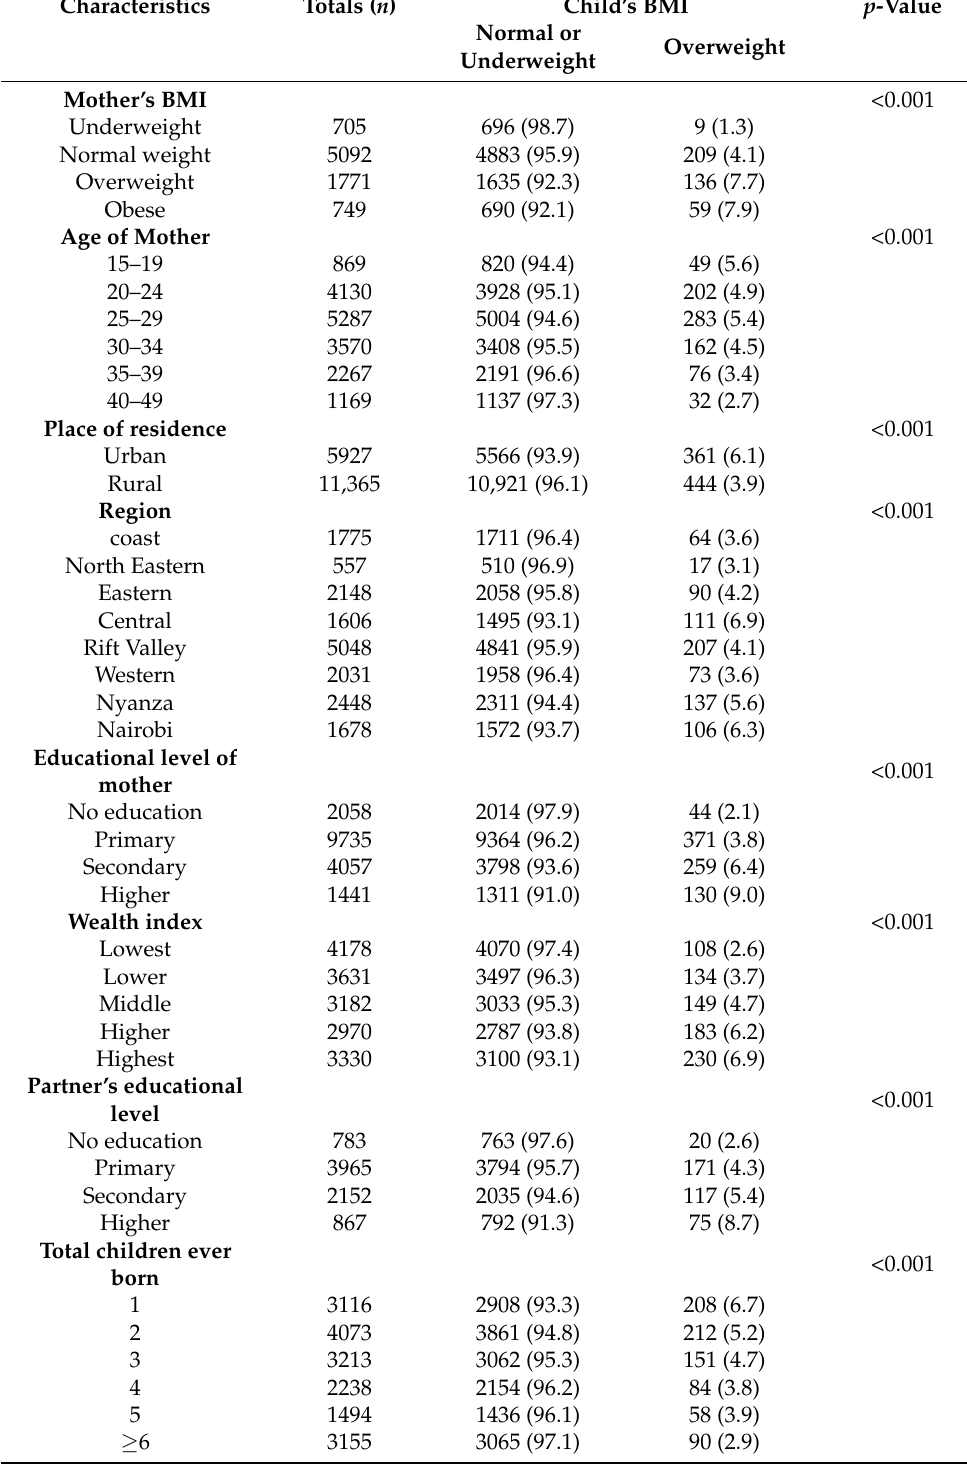
Table 2. Distribution of maternal demographic and child-related factors by child’s body mass index